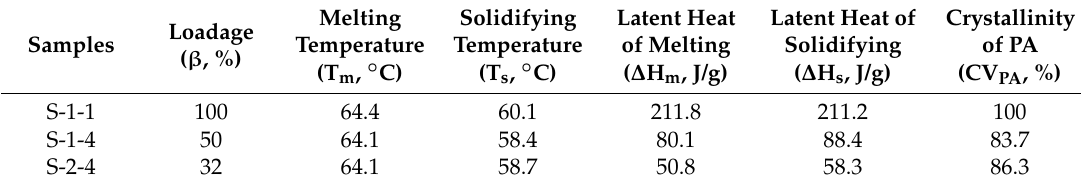
Figure 5. Differential Scanning Calorimeter (DSC) curves of pure PA, 50%PA/50%mullite and 32%PA/68%mullite. Table 2. The thermal properties of the PA/mullite composites.